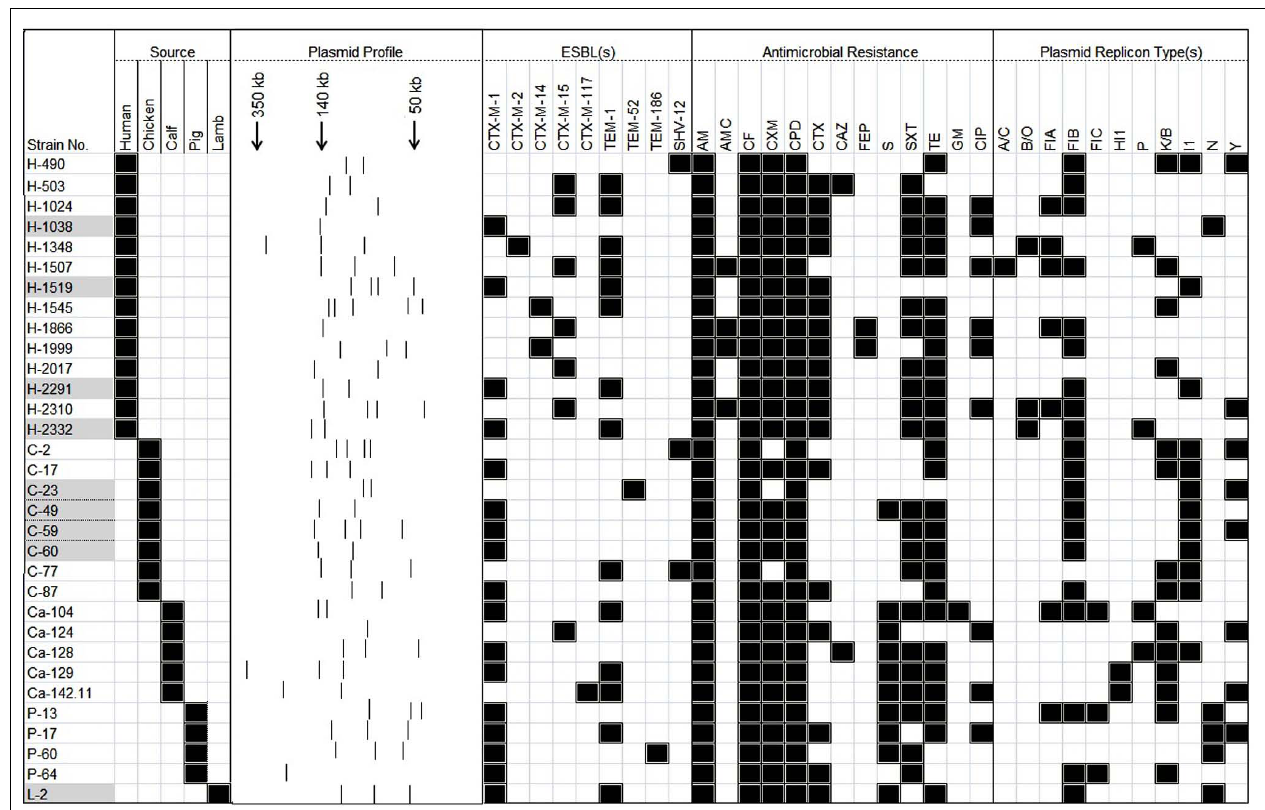
FIGURE 1 |A heat-map summary of the sources; a schematic showing the S1 nuclease plasmid profile; ESBL present/absent profiles; the resistance profile and the corresponding Inc plasmid type(s) for all 32 ESBL-positive E. coli previously reported from healthy food-producing animals and humans in Switzerland. Black squares shown indicate a feature present in that isolate denoting its original source the ESBL marker(s) detected, its corresponding antimicrobial resistance profile and the Inc types detected.White squares denote features that are lacking in the corresponding bacterial isolate. Isolate numbers denotes by the grayed boxes on the left of the heat-map indicate those bacteria that contained self-transmissible